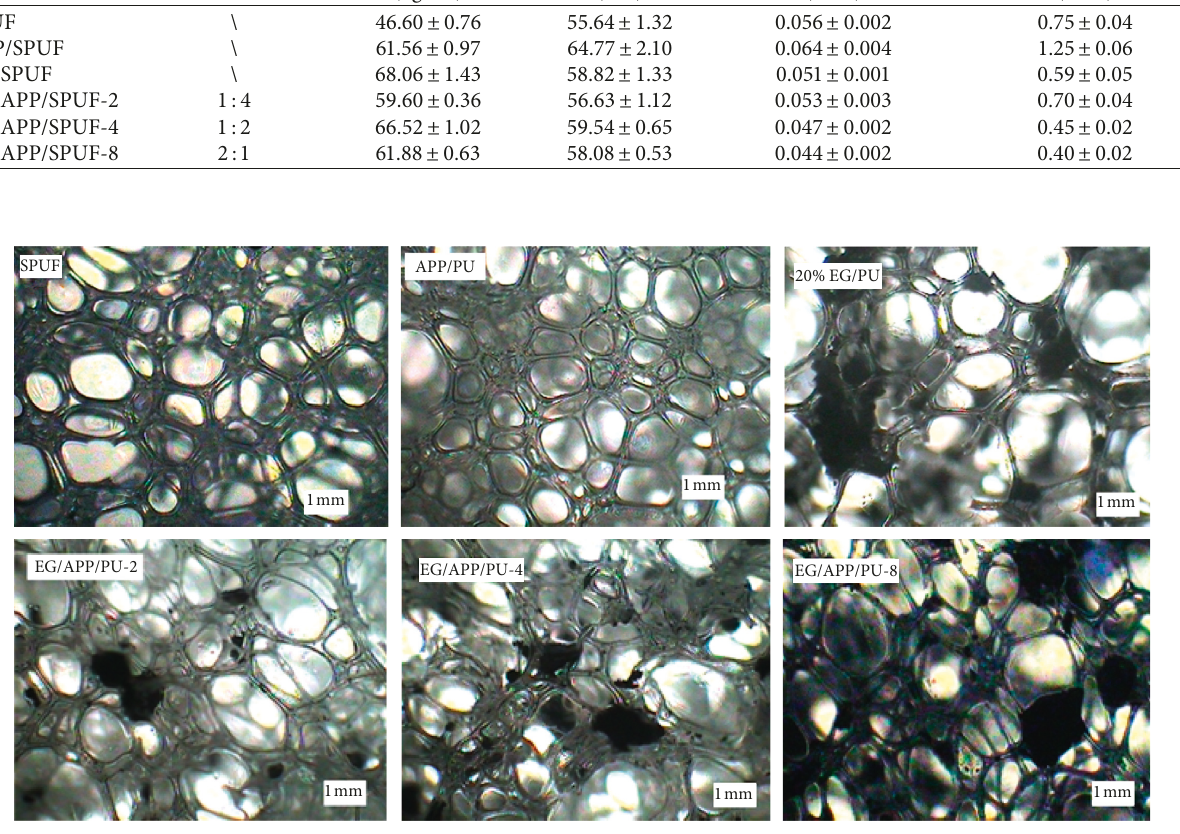
Figure 3: POM morphology of SPUF